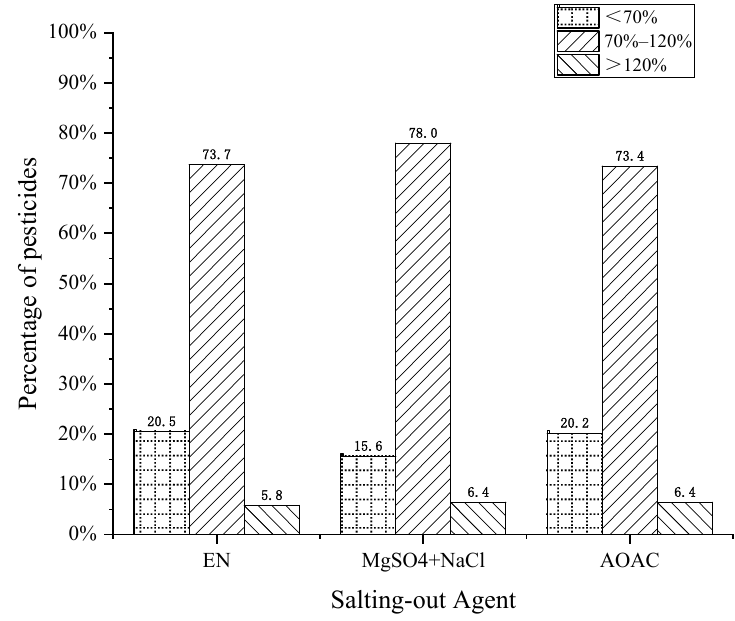
Figure 3. Effect of salting-out agents on pesticide